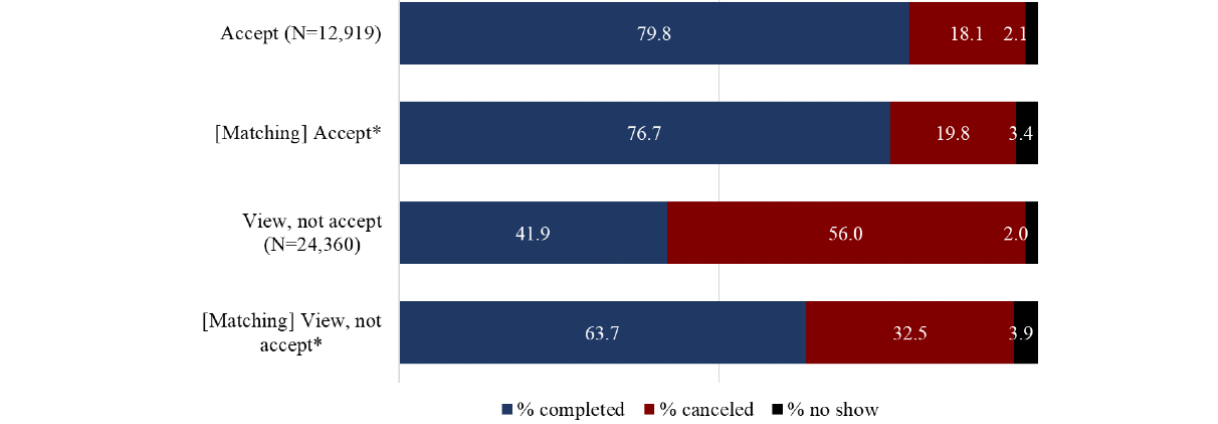
Figure 2. Appointment outcomes by Fast Pass offer status. * indicates matching comparison groups of "accept" and "view, not accept" groups,